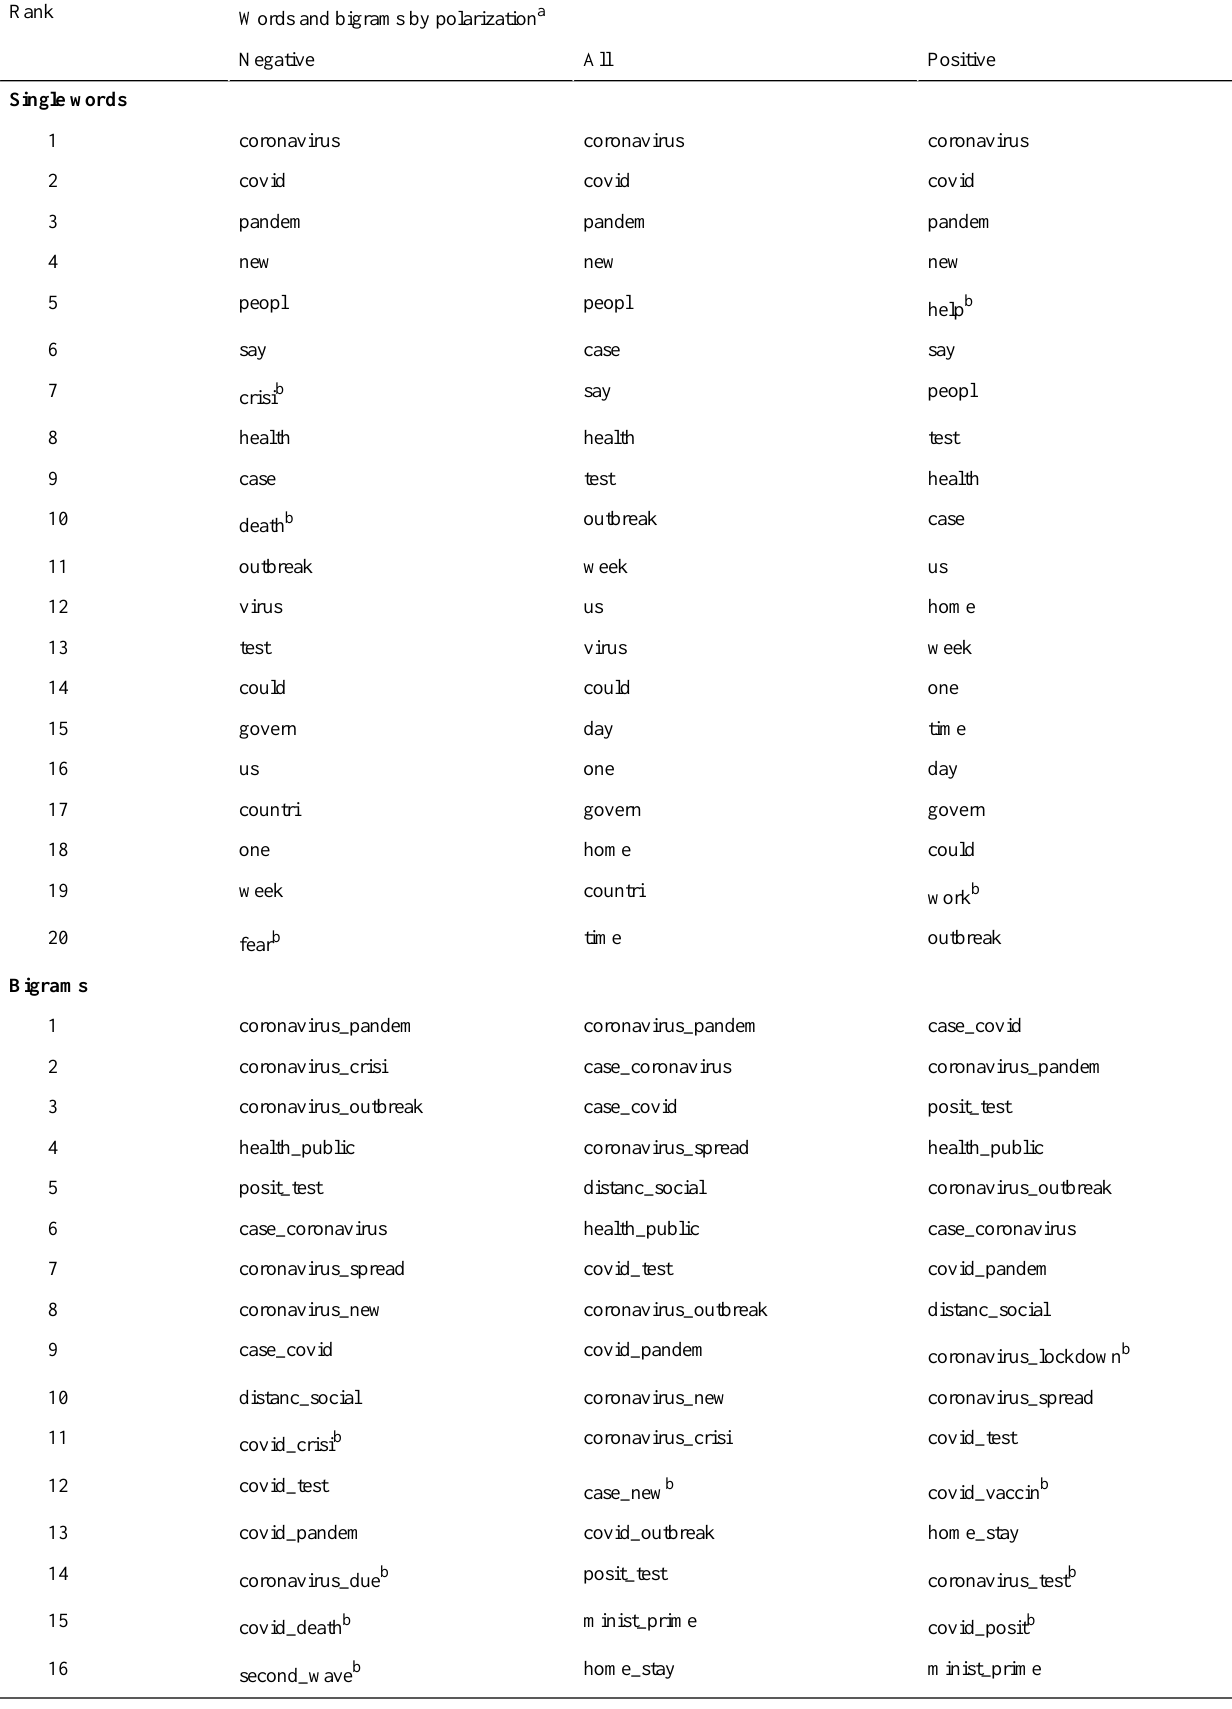
Table 5. Top words and bigrams in English-language countries.